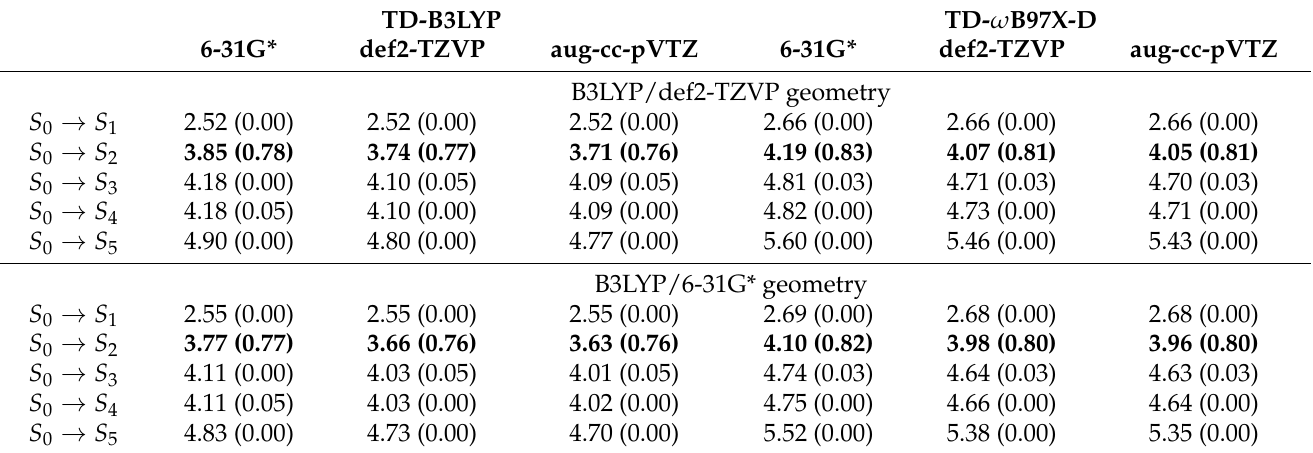
Table 1. Vertical excitation energies in eV and oscillator strengths (in parentheses) of the lowest five electronic transitions of trans azobenzene calculated with TD-B3LYP and TD- ω B97X-D and three basis sets (6-31G*, def2-TZVP, aug-cc-pVTZ) at the B3LYP/def2-TZVP and B3LYP/6-31G* optimized geometries. The brightest transitions are shown in bold.